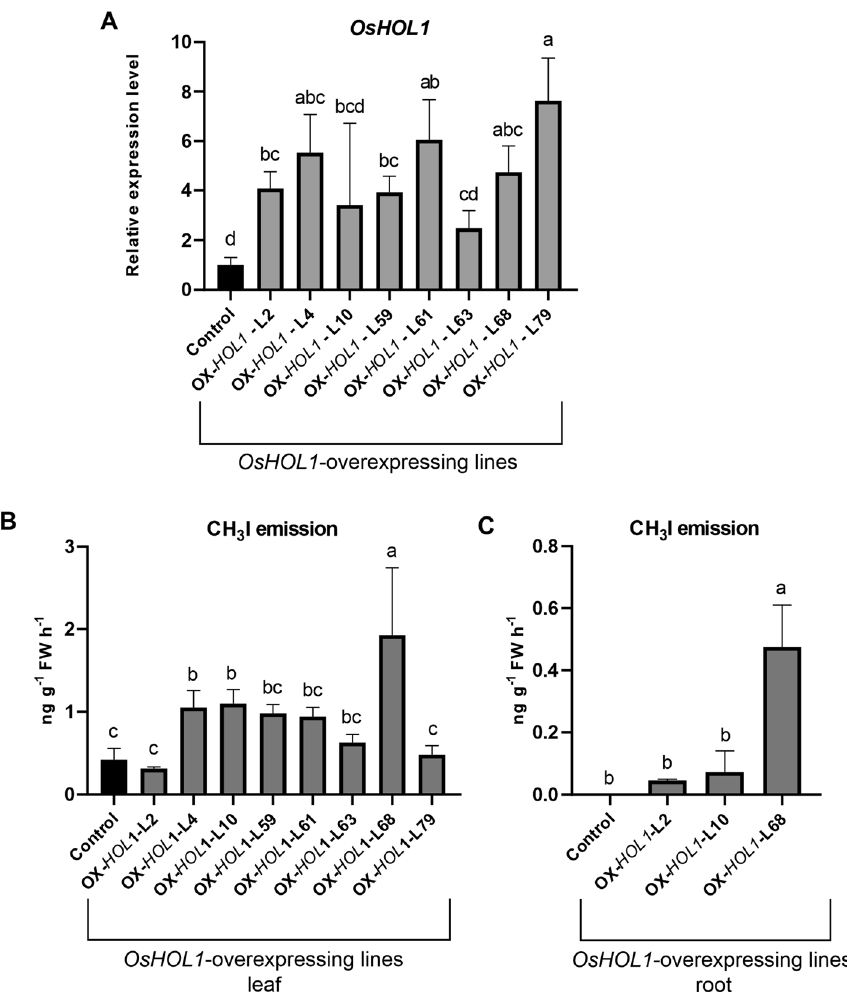
Figure 3. RT-qPCR and methyl iodide emission analyses in OsHOL1 overexpressing lines. ( A ) Transcript levels of OsHOL1 were measured in 2-week-old plants and expressed as relative values in comparison to the expression of control wild type plants. Values represent the means ± s.d. from three biological replicates. Data were subjected to one-way ANOVA. Values followed by the same letter are not significantly different (Tukey’s post-hoc test, P ≤ 0.05). CH 3 I emissions measured from leaves ( B ) and roots ( C ) collected from OsHOL1 overexpressing plants. Air samples from leaves or roots were analyzed 24 h after incubation with 0.5 mM KI. Data points are the mean ± s.d. of four biological replicates for each line and two technical replicates per each biological sample. Data were subjected to one-way ANOVA. Values followed by the same letter are not significantly different (Tukey’s HSD post-hoc test, P ≤